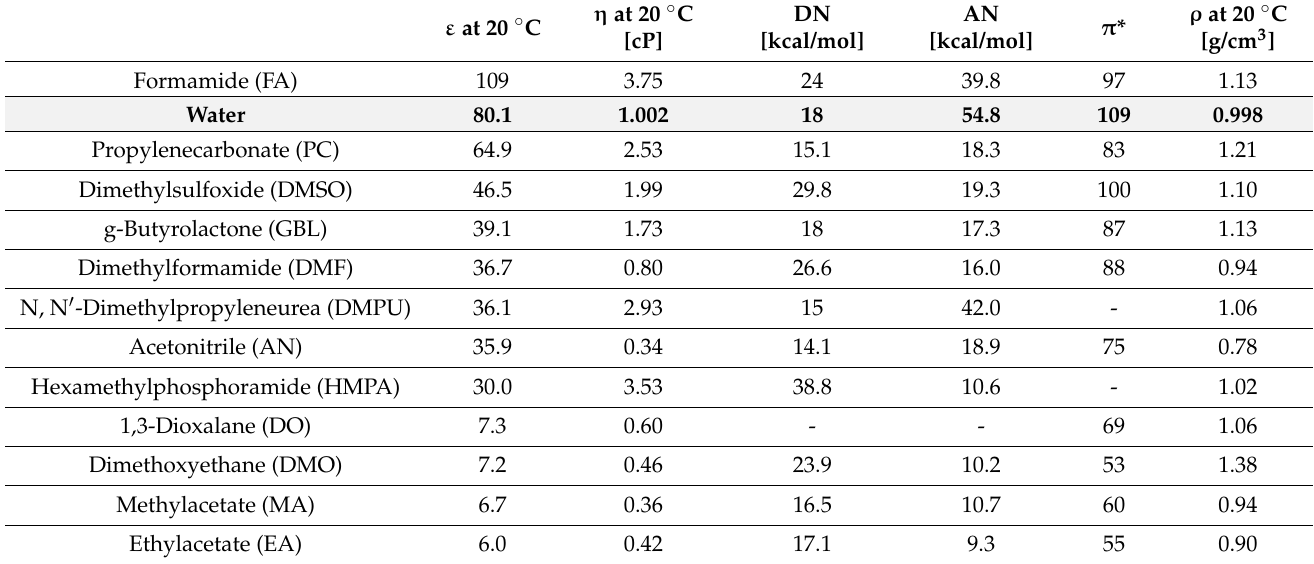
Table 2. Physico-chemical properties [8–12] of typical organic solvents in electrochemistry arranged according to their permeability ( ε